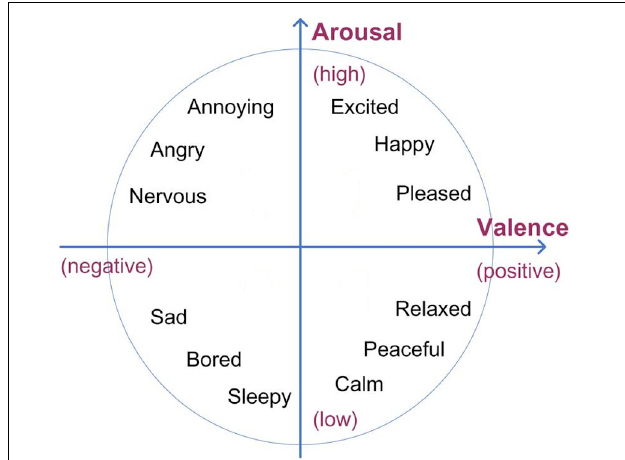
FIGURE 3 | Thayer’s arousal-valence emotional